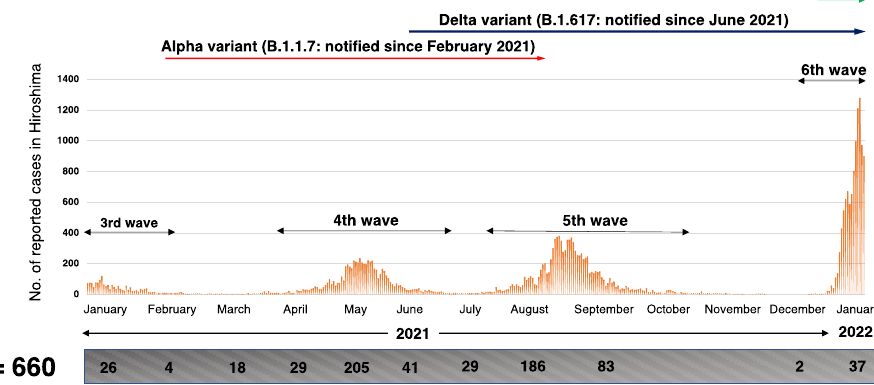
Figure 1. Distribution of study subjects. The upper bar graph represents the number of COVID-19 cases in Hiroshima on a daily basis, which is reported at the Hiroshima Prefectural Health and Welfare Bureau. The number of samples is shown in the box below the bar graph on a monthly basis.